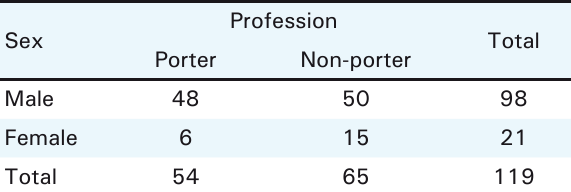
2. Sex wise frequency of porters and non-